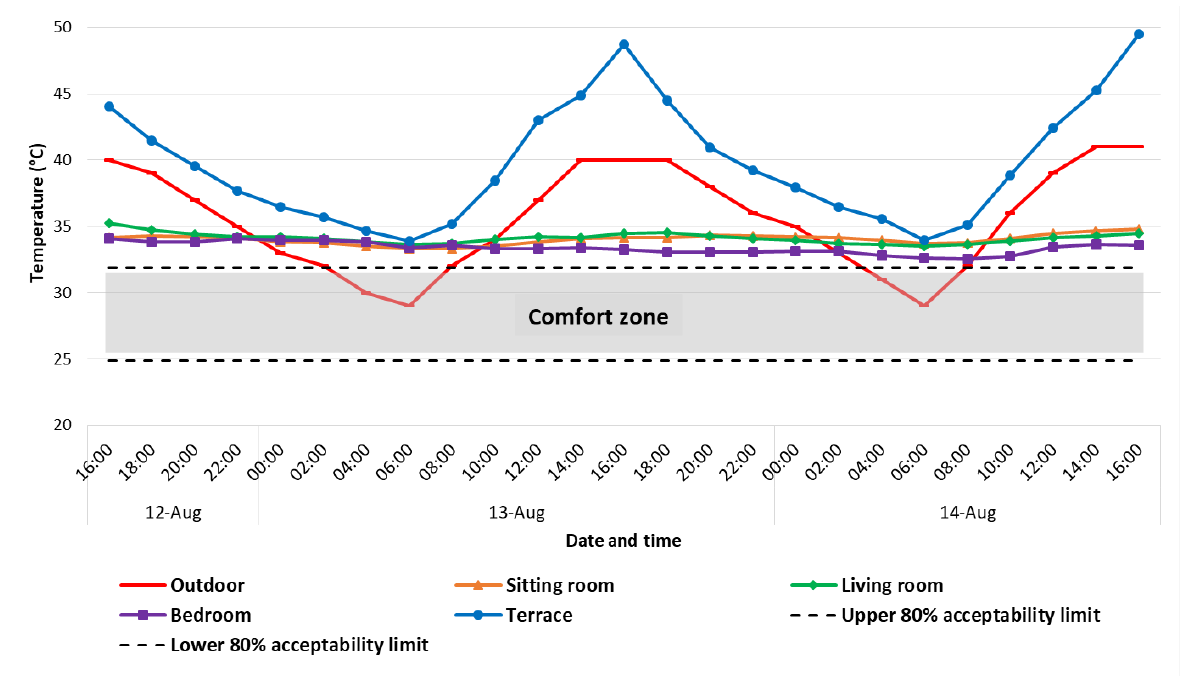
Figure 15. Variations in the operative temperature.